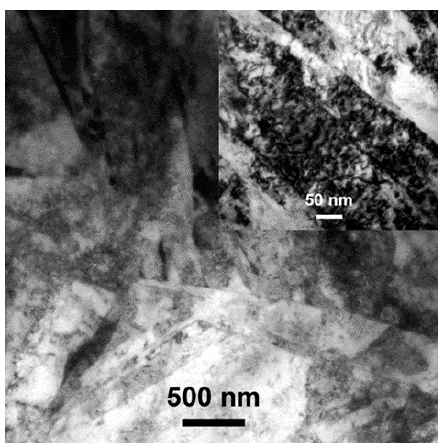
Figure 7. TEM micrograph of typical martensite laths of the hardened 22MnB5.